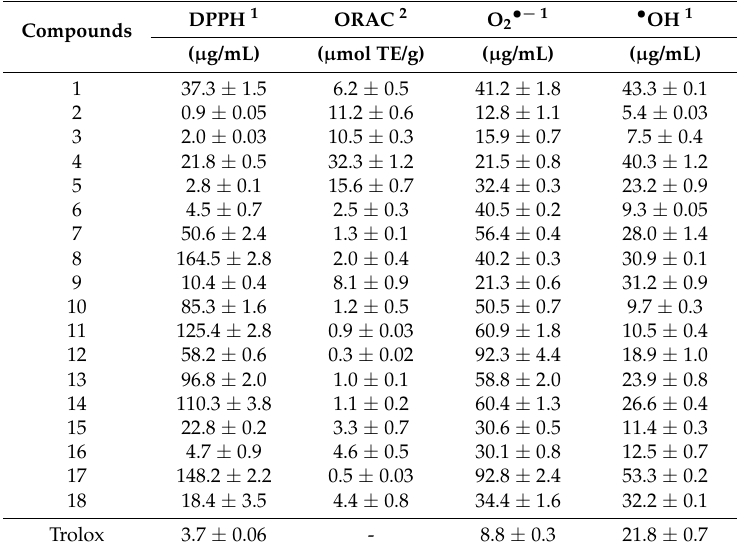
Table 2. Radical scavenging activities of phenolic compounds 1 – 18